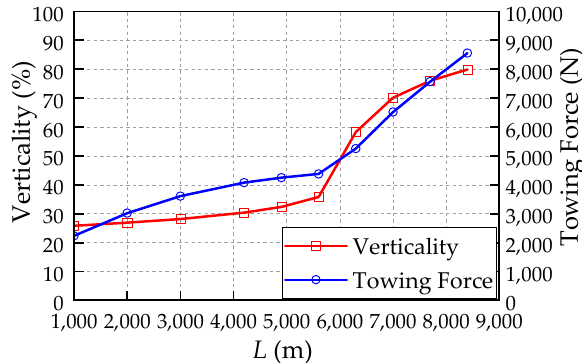
Figure 13. Verticality and towing force vs. towline length.